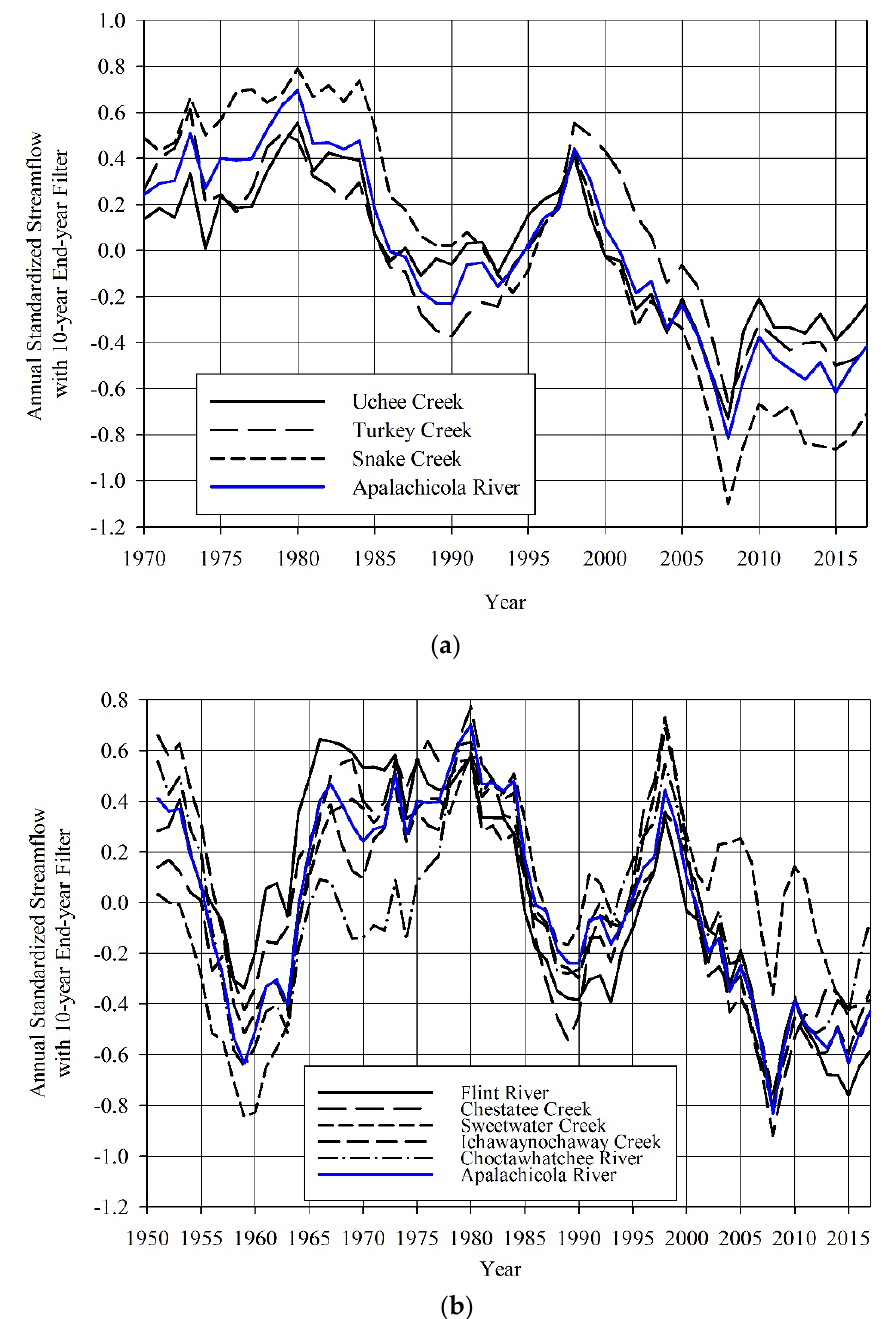
Figure 2. Annual standardized streamflow with 10-year end-year filter ( a ) Streamflow: 1970-2017 (based on annual data of 1961-2017) ( b ) streamflow: 1951-2017 (based on annual data of 1942-2017).